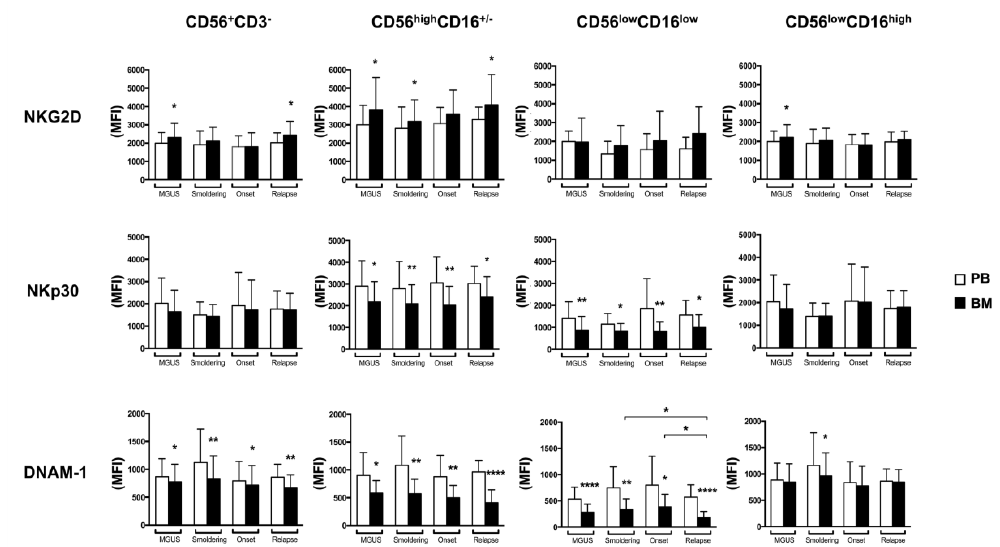
Figure 2. BM and PB NK cell subsets receptor profile of MM patients during disease progression. FACS analysis of surface expression of NKG2D ( A ) , NKp30 ( B ) and DNAM-1 ( C ) on total NK cells and NK cell subsets in PB (white histograms) and BM (black histograms) of MM patients at different state disease (MGUS, n = 19; Smoldering, n = 18; Onset, n = 18; Relapse, n = 17) was shown. Values are expressed as mean of mean fluorescence intensity (MFI) and error bars represent SD. **** p < 0.0001; ** p < 0.01; * p < 0.05.